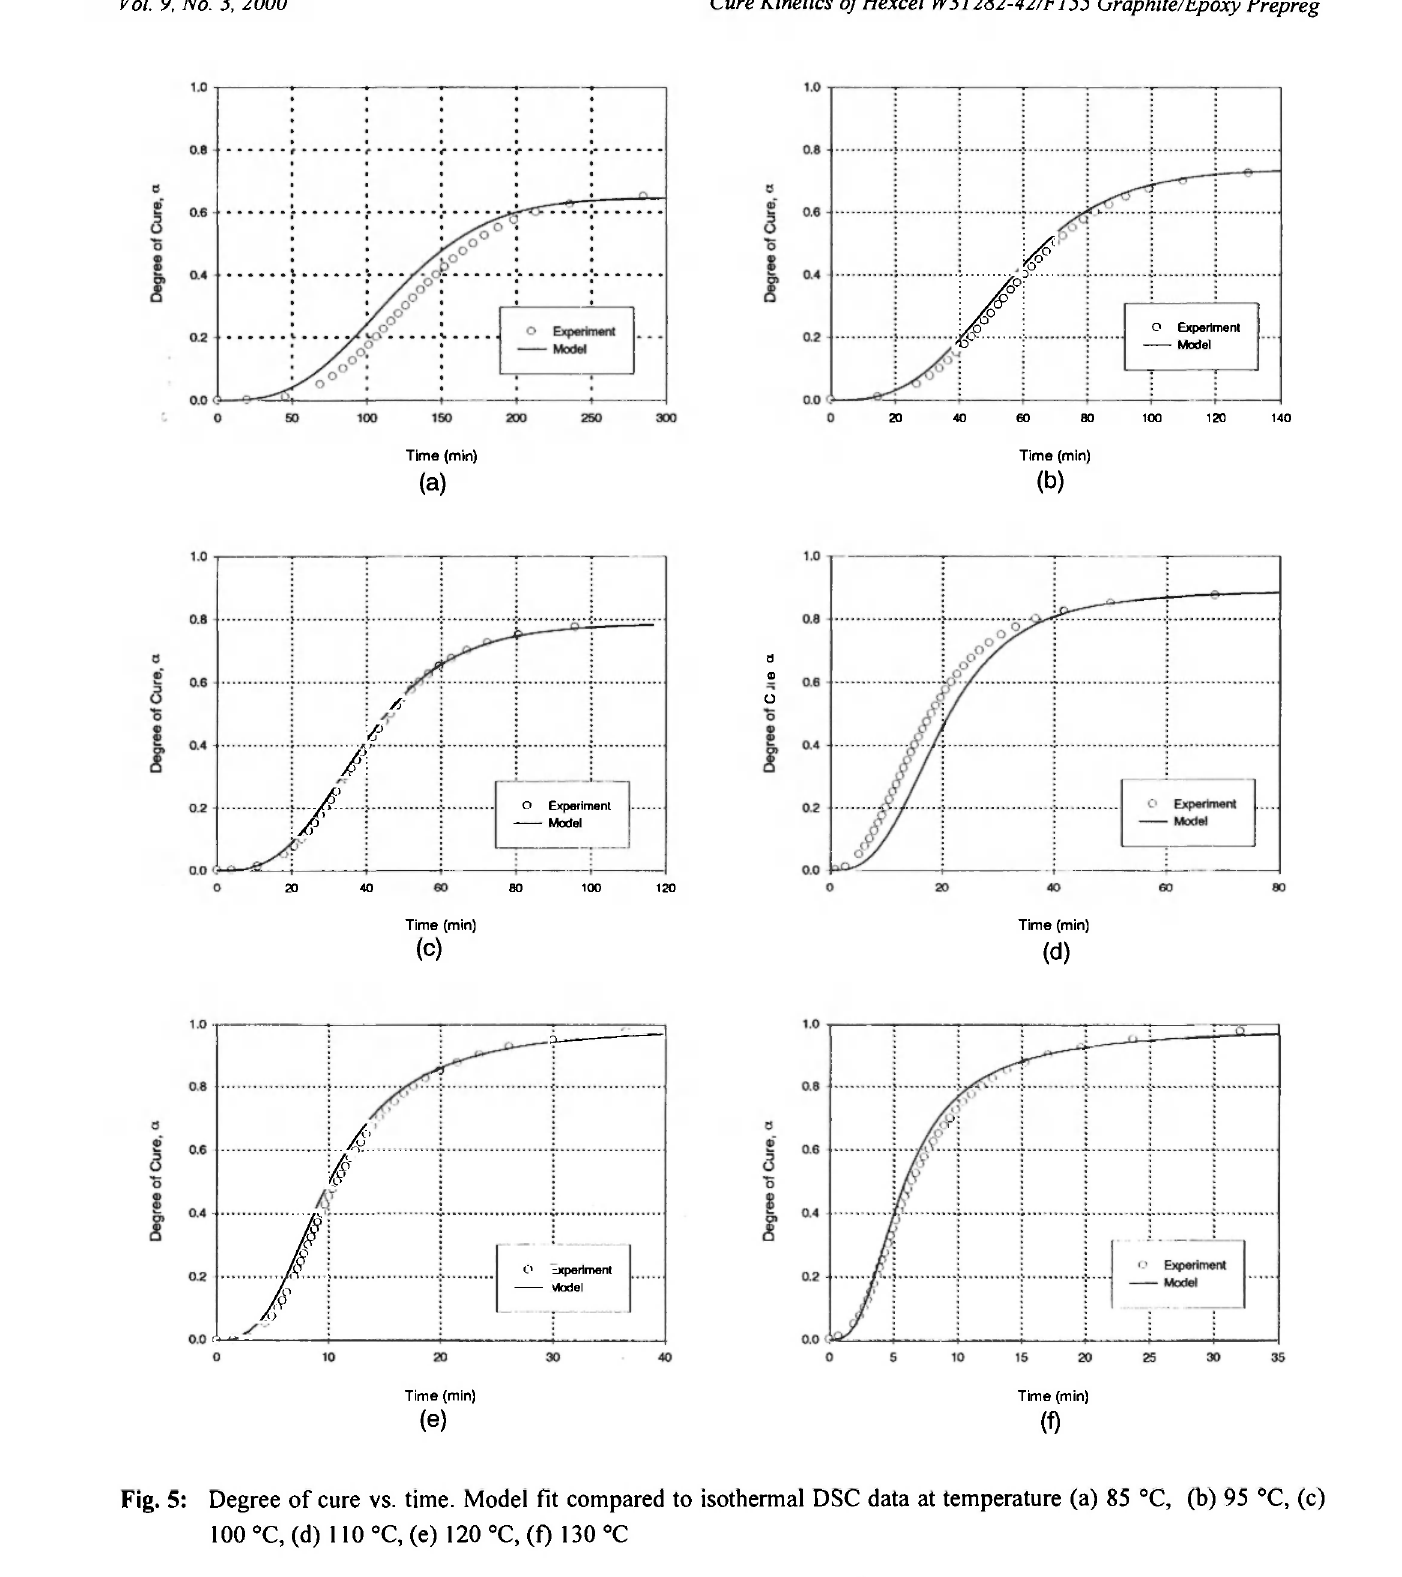
Fig. 5: Degree of cure vs. time. Model fit compared to isothermal DSC data at temperature (a) 85 °C, (b) 95 °C,